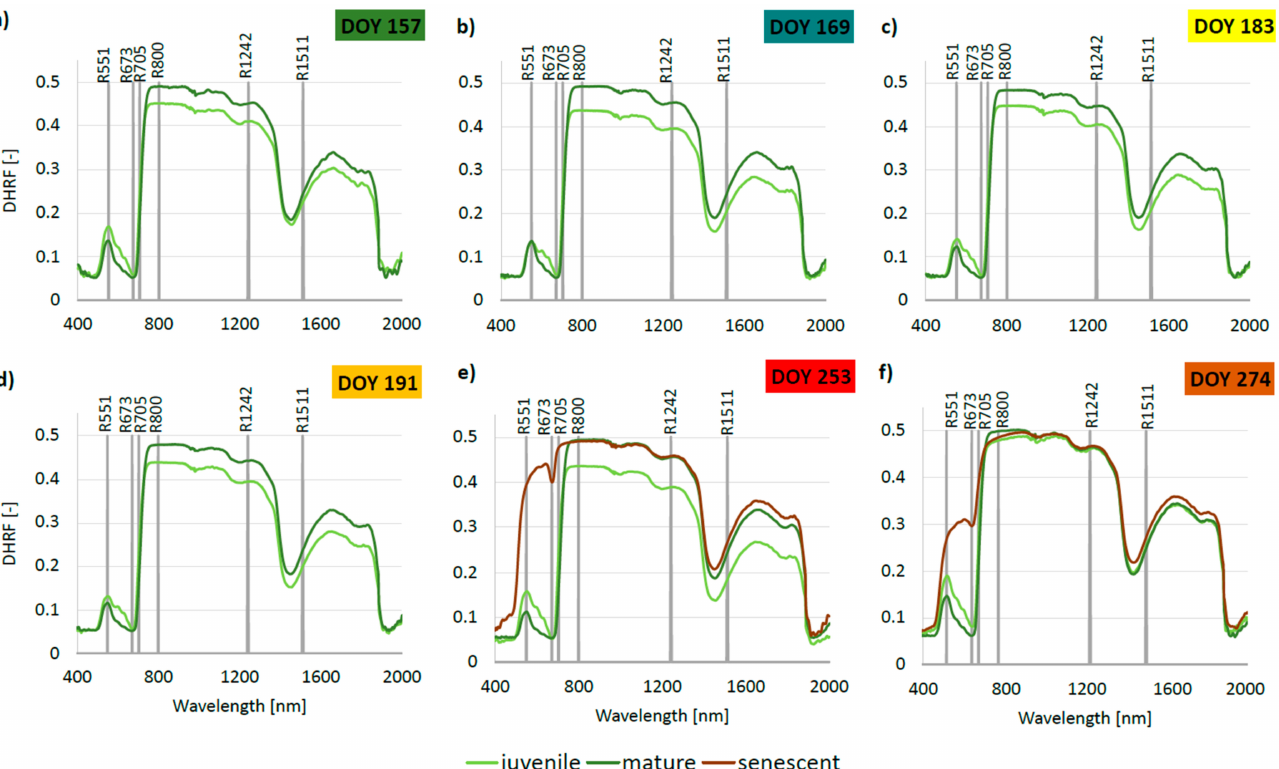
Figure 6. The mean values of Directional-Hemispherical Reflectance Factor (DHRF) for different leaf developmental categories (juvenile, mature, and senescent) during the season: ( a ) DOY 157; ( b ) DOY 169; ( c ) DOY 183; ( d ) DOY 191; ( e ) DOY 253; ( f ) DOY 274. Grey vertical lines correspond to reflectance in selected wavelengths representative for red, green, red-edge, NIR, and SWIR spectral regions that were evaluated for differences by ANOVA (see Supplementary Figures